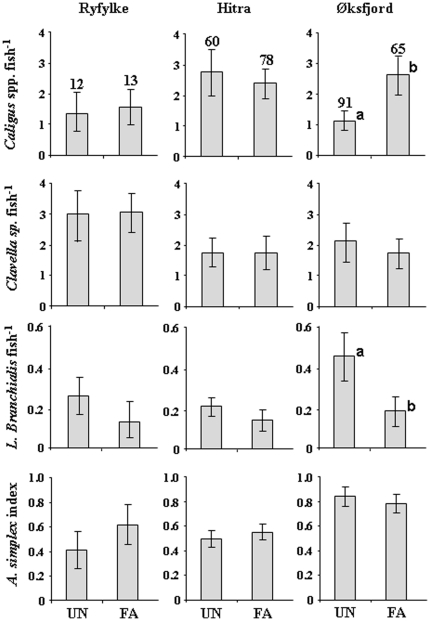
Mean abundances (± SE) of common parasites of farm-associated (FA) and un-associated (UA) Atlantic cod Gadus morhua in each of the three intensive salmon farming areas.HSI = Hepatosomatic index. Superscripts (a,b) indicate a significant difference was detected between the two groups at the p<0.05 level. Numbers above bars give the number of fish sampled for each comparison.